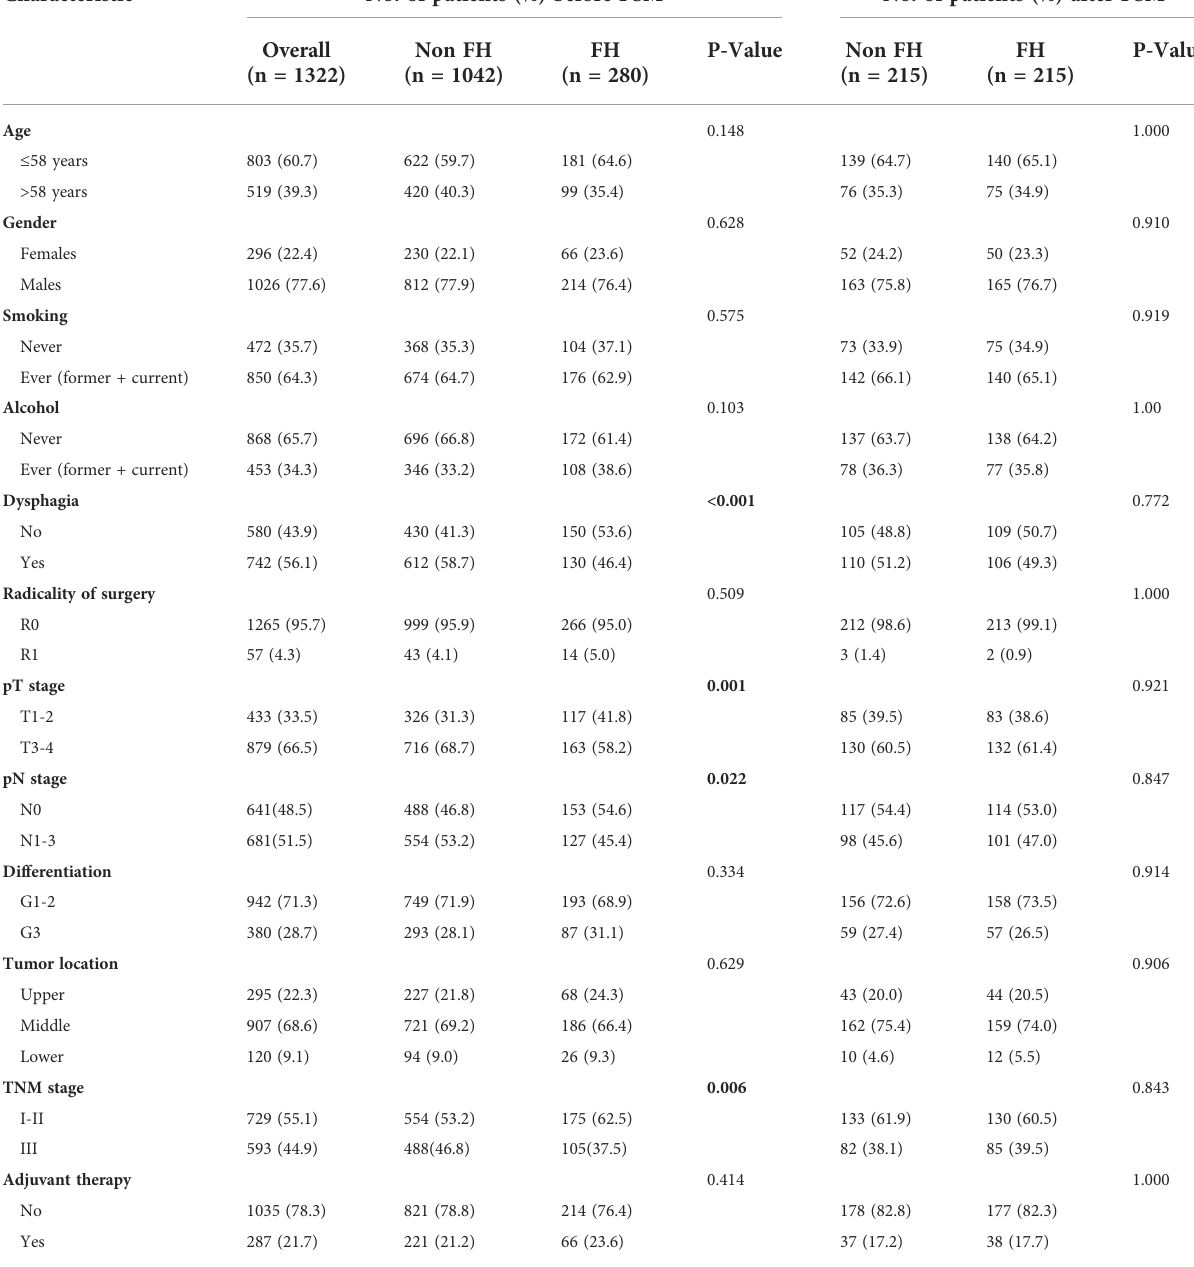
TABLE 1 The clinical and pathologic characteristics at